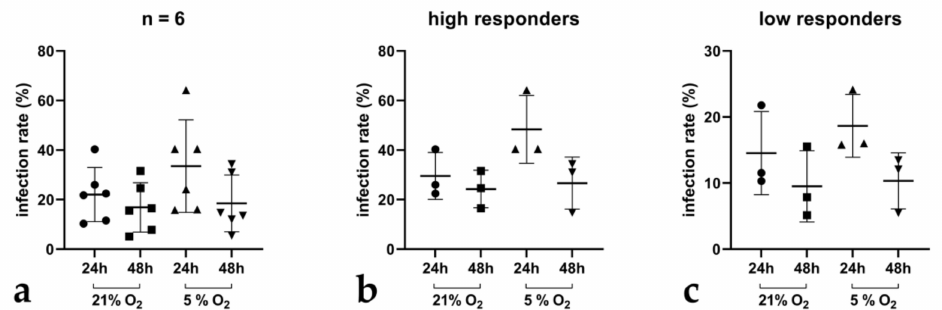
Figure 6. Cryptosporidium parvum development in BSIEC under physioxic and hyperoxic conditions. In total, 6 individual BSIEC isolates were generated and thereafter infected with freshly excysted C. parvum sporozoites ( a ). Within these populations, high ( b ) and low ( c ) infected BSIEC isolates were